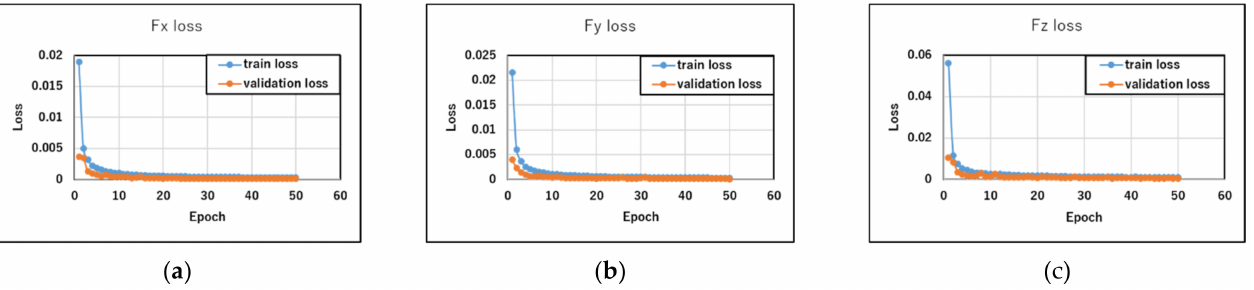
Figure 5. Variation in loss: ( a ) F x ; ( b ) F y ; ( c ) F z .